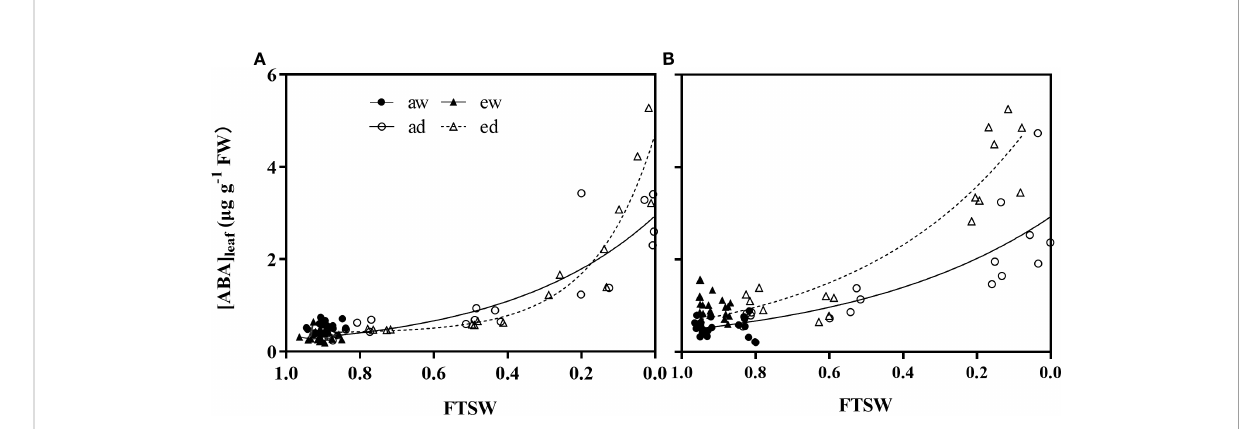
FIGURE 7 Changes of leaf ABA concentration of (A) wheat and (B) maize plants under ambient (400 ppm, a[CO 2 ]) and elevated (800 ppm, e[CO 2 ]) atmospheric CO 2 concentrations during progressive soil drying.